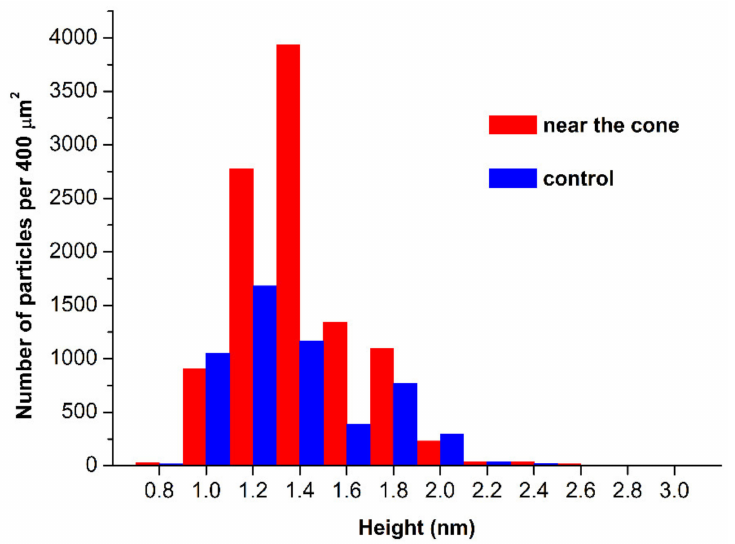
Figure 4. Absolute height distributions of objects visualized by AFM on mica substrates incubated near the top of the cone with the power supply turned on (red bars) or off (blue bars). The abso- lute distribution indicates the number of particles normalized to a scanned area of 400 µ m 2 . The experimental error was ± 250 particles per 400 µ m 2